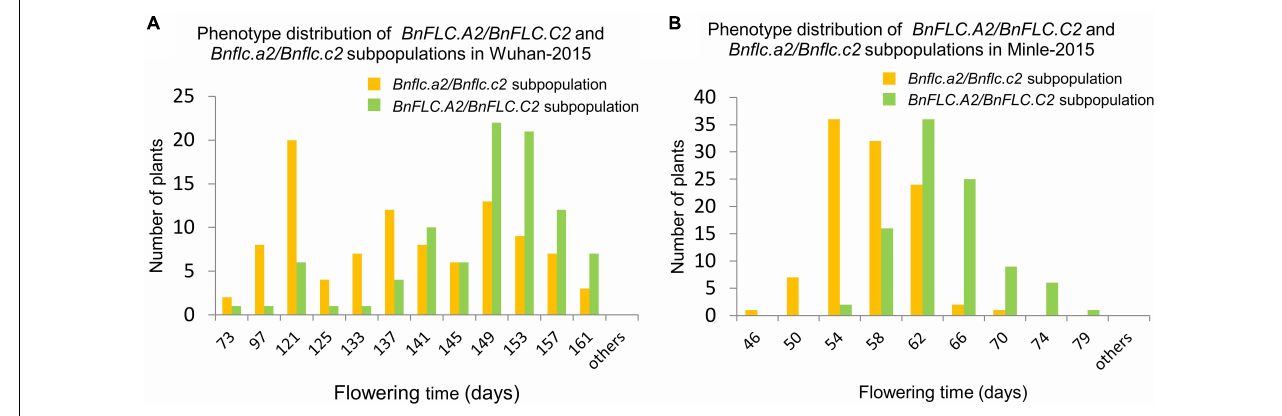
FIGURE 1 | Histogram of phenotype distribution of the subpopulations from the double haploid population constructed by crossing 616A and R11 in the Wuhan-2015 and Minle-2015 environments. (A) Phenotype distribution of BnFLC.A2 / BnFLC.C2 and Bnflc.a2 / Bnflc.c2 subpopulations in Wuhan-2015. (B) Phenotype distribution of BnFLC.A2 / BnFLC.C2 and Bnflc.a2 / Bnflc.c2 subpopulations in Minle-2015. The yellow color represented the Bnflc.a2 / Bnflc.c2 subpopulation, and the green color represented the BnFLC.A2 / BnFLC.C2